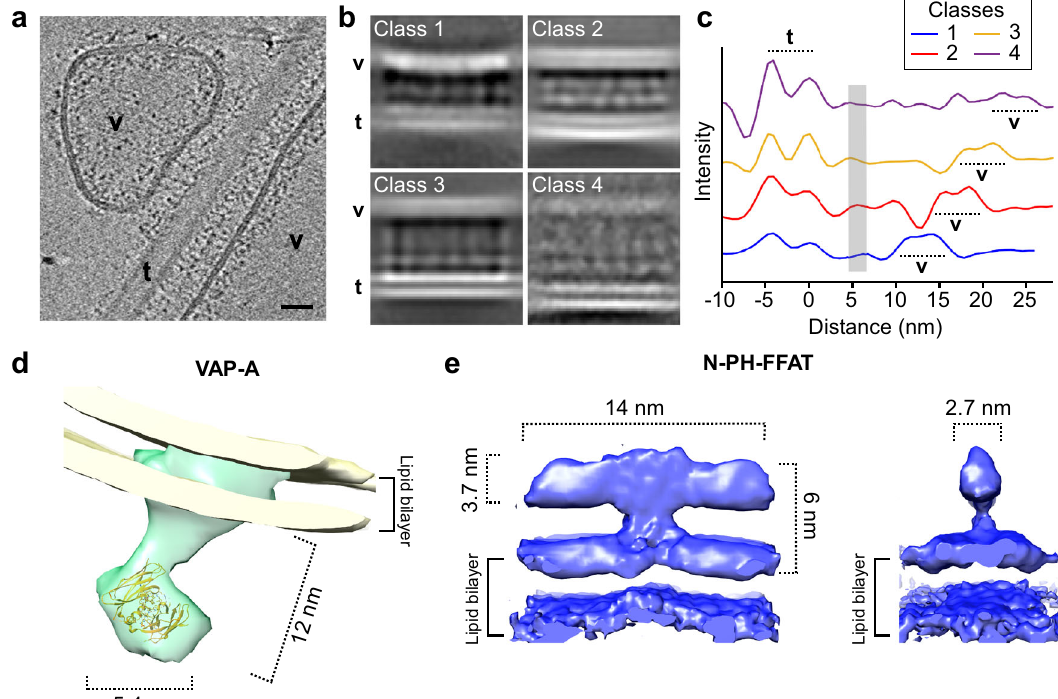
Fig. 4 3D molecular architecture of VAP-A N-PH-FFAT in reconstituted membrane contact sites (MCS). a Tomographic slice of VAP-A/NH-FFAT membrane contact site. Hemispherical vesicles (v) and large and fl at vesicles (v) contact a tube (t) decorated with N-PH-FFAT bound to. The lipid bilayer of both vesicles is visible while the lipid bilayer of the tube is out of the plane. Tiny protein densities tether v and t. Bar = 25 nm. b Classes of membrane contact sites after 3D classi fi cation. Electron densities of the lipid bilayer and proteins are depicted in white. The distance between facing membranes increases from class 1 to 4. Class 1 – 3 correspond to MCS formed with VAP-A vesicles and class 4 with VAP-A ribbons. c 2D plot of electron densities perpendicular to MCS of classes 1 – 4. The outer lea fl ets of the tubes were aligned at 0 nm. The two lipid lea fl ets of the tube are well resolved while the VAP-A membrane is less de fi ned and appears at increasing distance from class 1 to 4. In all classes, a protein density assigned to N-PH-FFAT domain is found at 5 – 6 nm from the tubes (gray line). d 3D volumes of VAP-A and e of N-PH-FFAT at 19.6 Å and 9.8 Å resolution, respectively. A representative tomographic slice or micrographs is shown from at least three